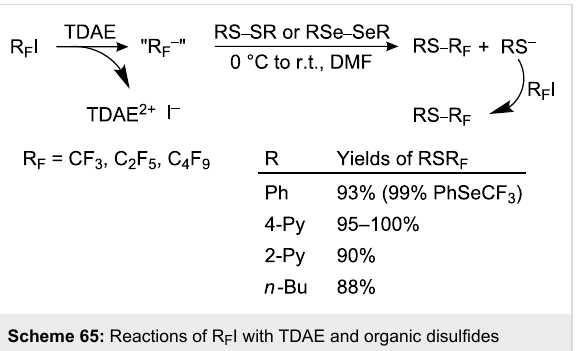
R R F Solvent T (°C)